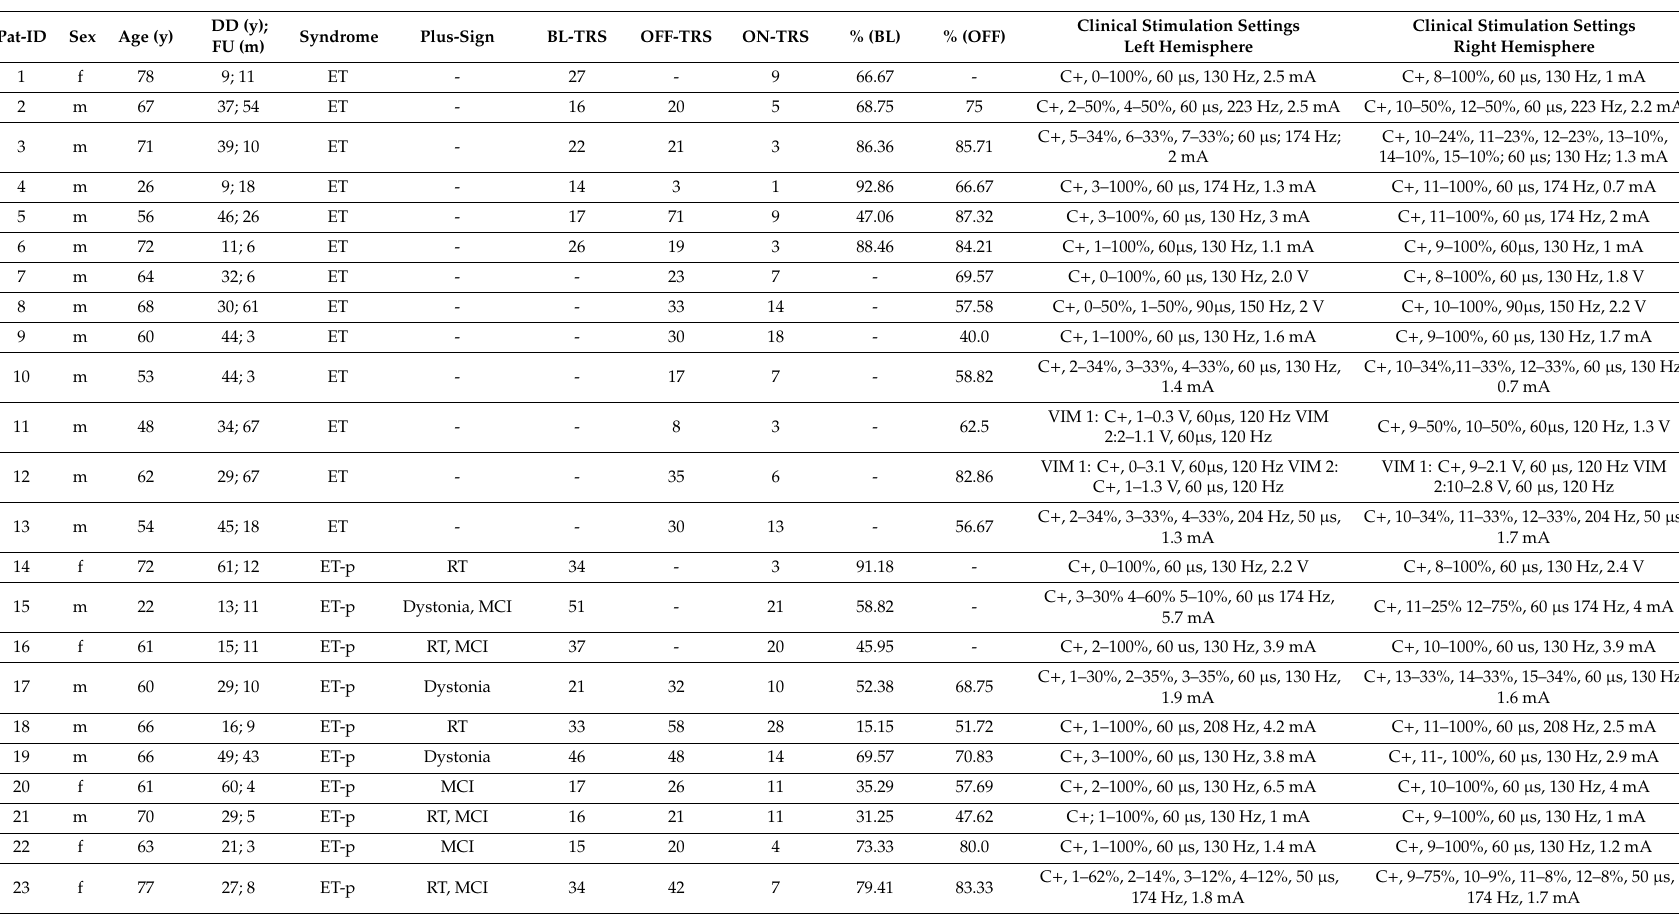
Table 1. Patient characteristics and individual TRS scores. Abbreviations: f = female; m = male; age = age at DBS implantation; DD = disease duration at DBS implantation; y = years; FU = follow-up (time between DBS implantation and TRS-scoring in months, m); RT = rest tremor; MCI = mild cognitive impairment; BL = baseline; OFF = stimulation OFF; ON = stimulation ON; % (BL) = tremor reduction in percent in ON compared to baseline; % (OFF) = tremor reduction in percent in ON compared to